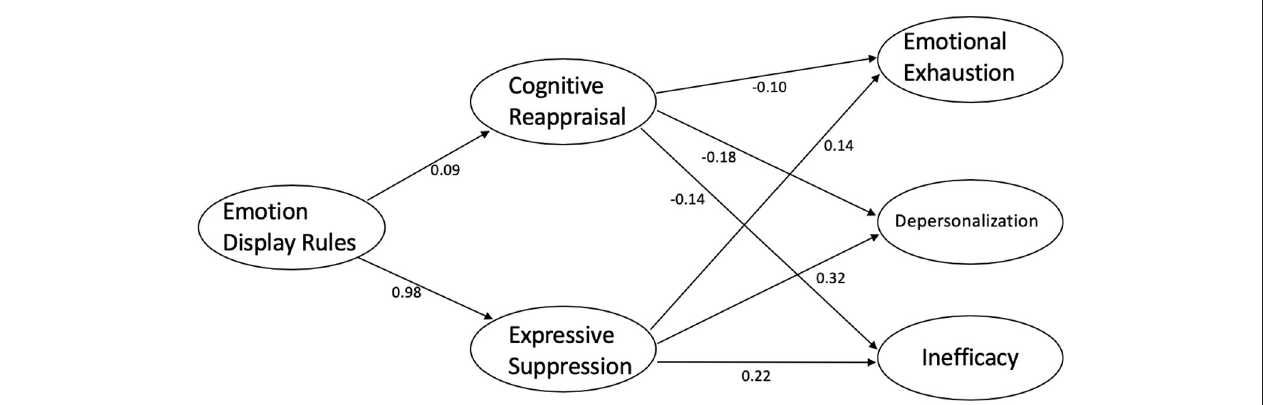
FIGURE 2 | Structural equation model. 1. All paths were significant except the path from emotion display rules to reappraisal. 2. Fit indices: χ 2 = 506.42, df = 178, RMSEA = 0.05, SRMR = 0.04, GFI = 0.92, and CFI = 0.97. 3. See Table 2 for t -values of paths, direct and indirect effects among variables.